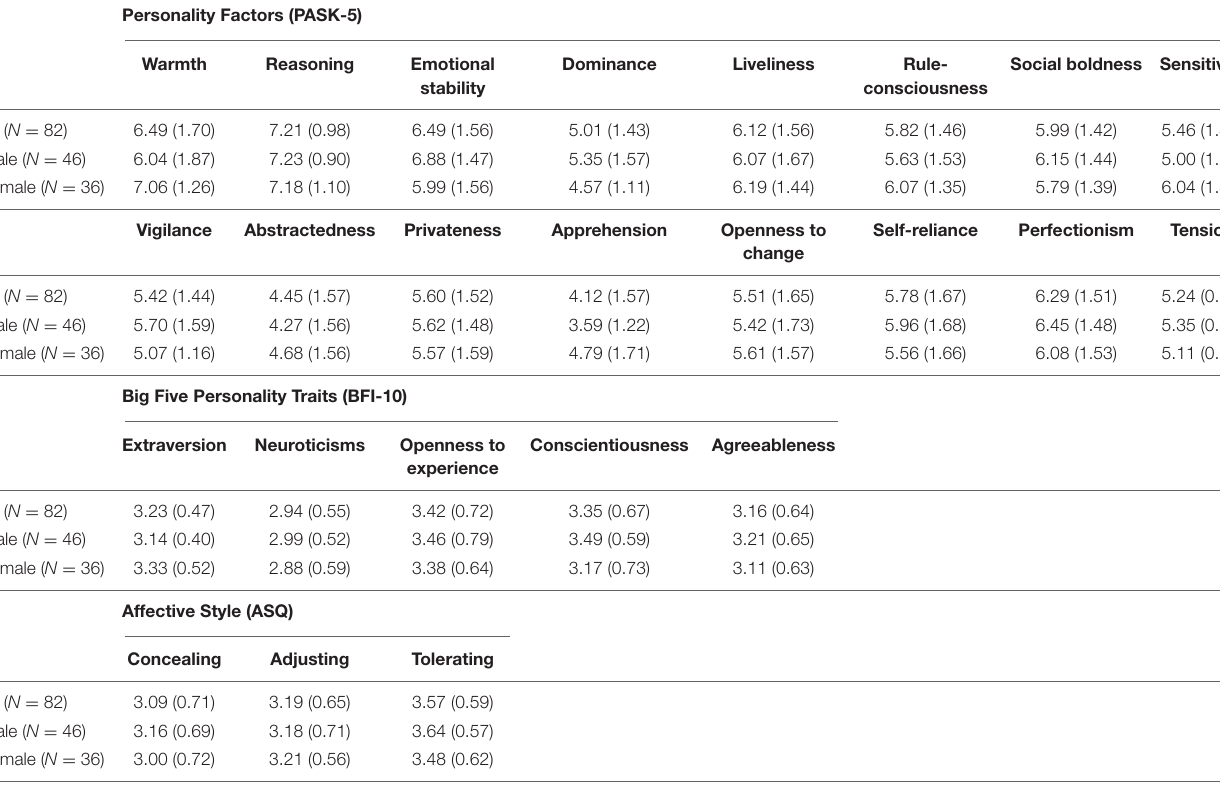
TABLE 1 | Mean values (and standard deviations) of the personality questionnaires and emotion regulation style of elite beach volleyball